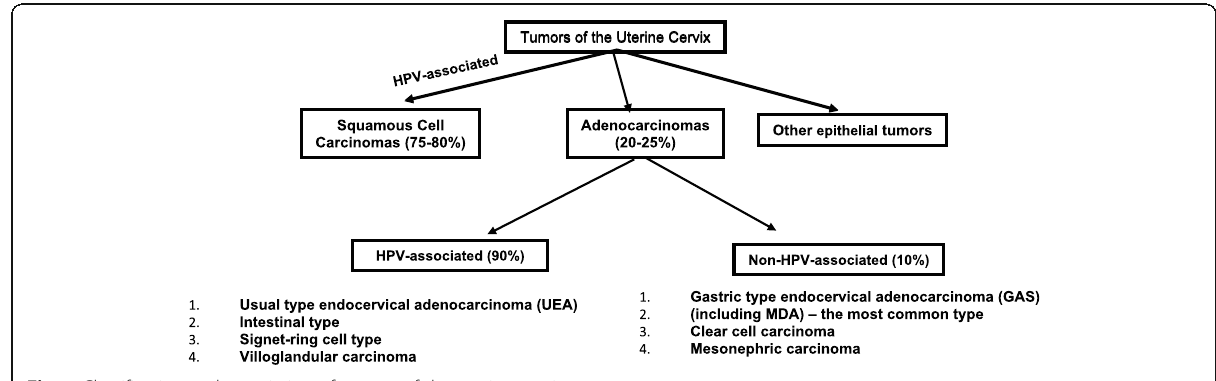
Fig. 1 Classification and association of tumors of the uterine